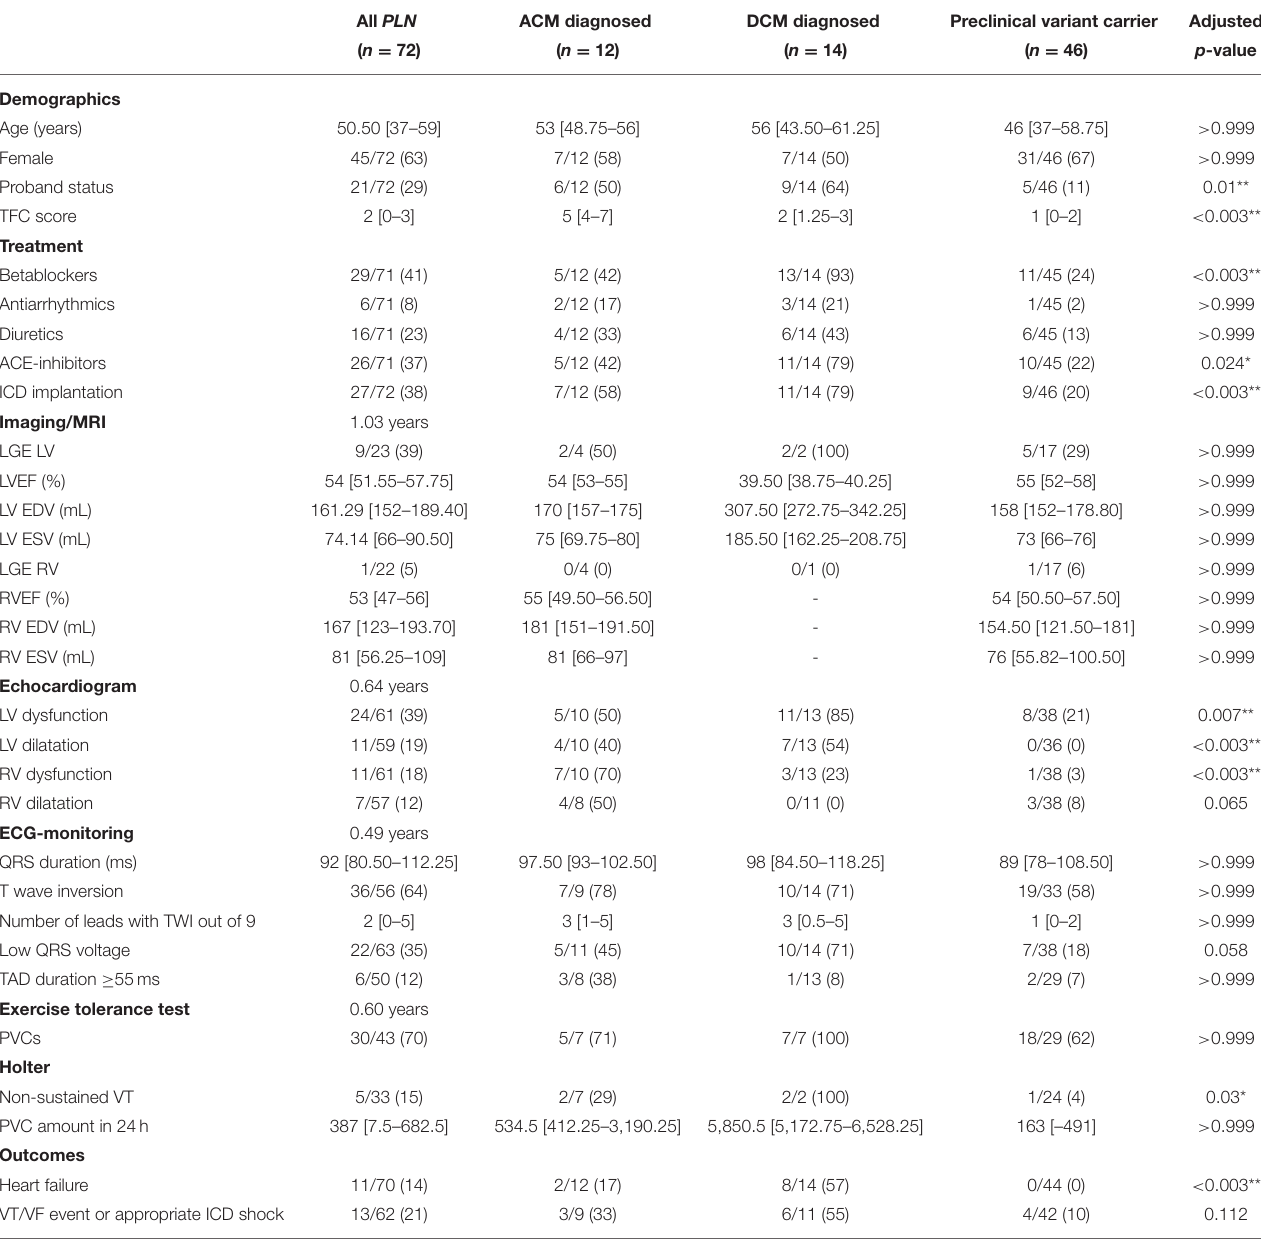
TABLE 1 | Patient characteristics of included PLN variant